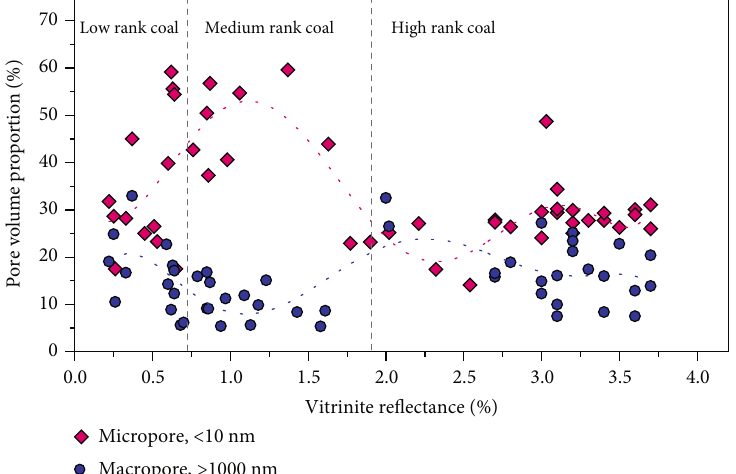
Figure 9: Relationship between vitrinite re fl ectance and pore volume of di ff erent kinds of pores (the data is cited from references [33 – 37]).